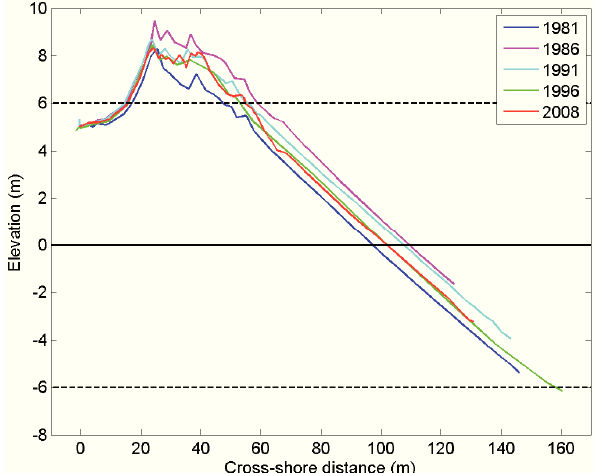
Figure 1. Advocate Beach profile history. Note the 1:10 slope, constant through time. Dashed black lines indicate the nominal low and high tide levels, solid black line the mid-tide level. (Data courtesy of Bob Taylor, Natural Resources Canada.)